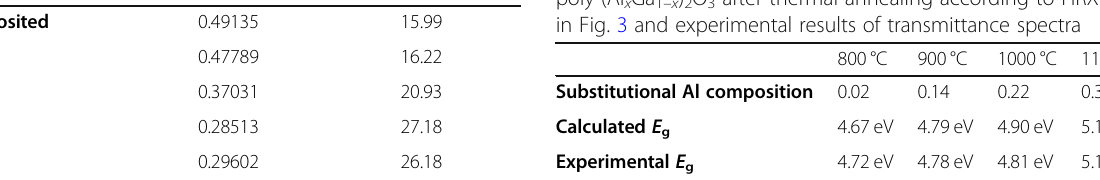
Table 2 Comparison of the calculated Al content and E g